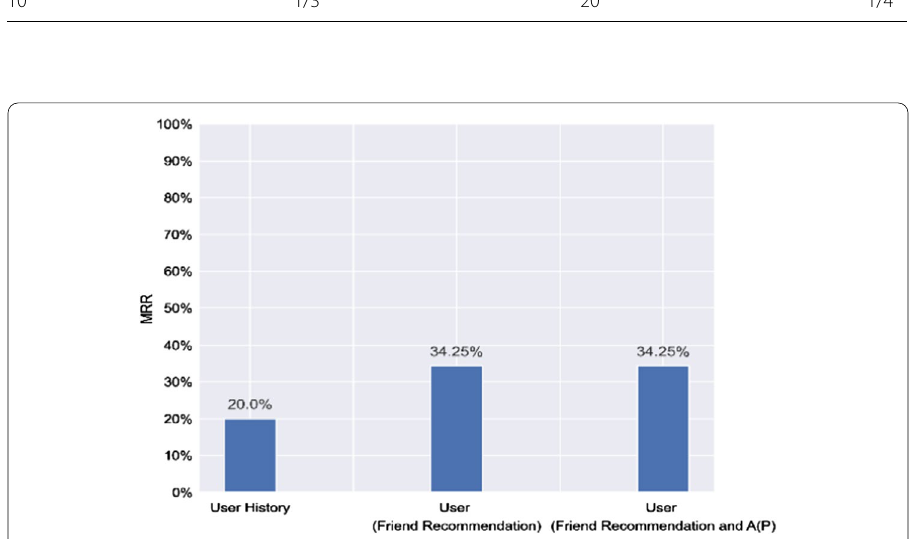
Fig. 10 Comparison of the results of new users’